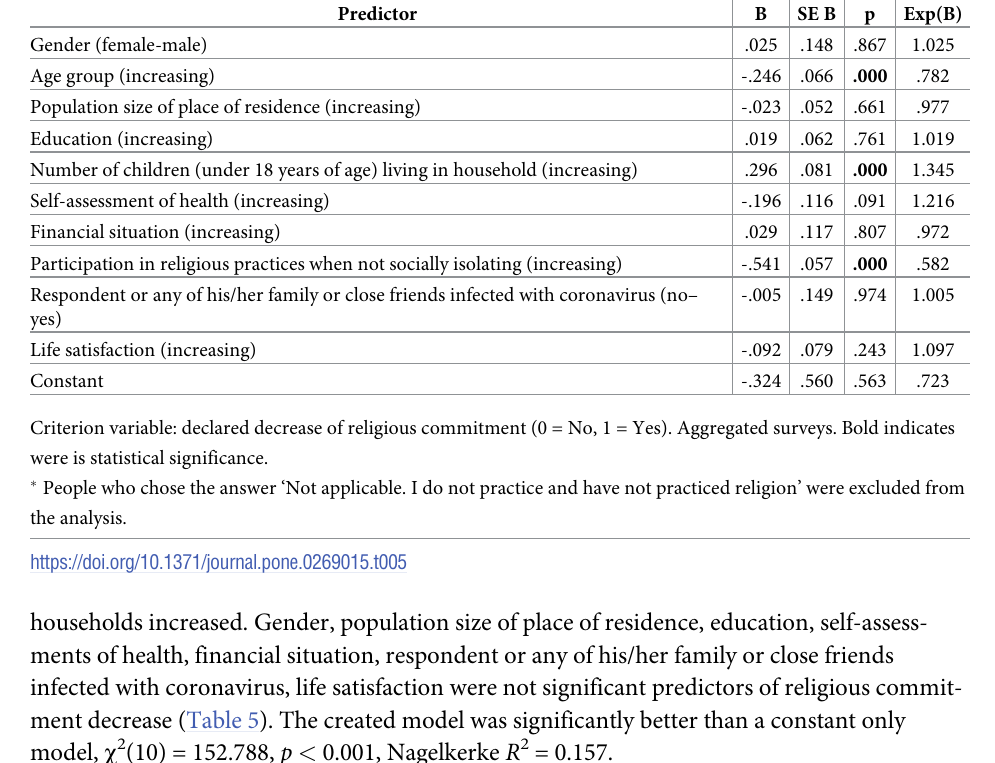
Table 6. Religiosity before the pandemic and religious commitment during the pandemic ( N = 1761). How often do you usually attend masses, services or other religious meetings? (when not socially isolating)